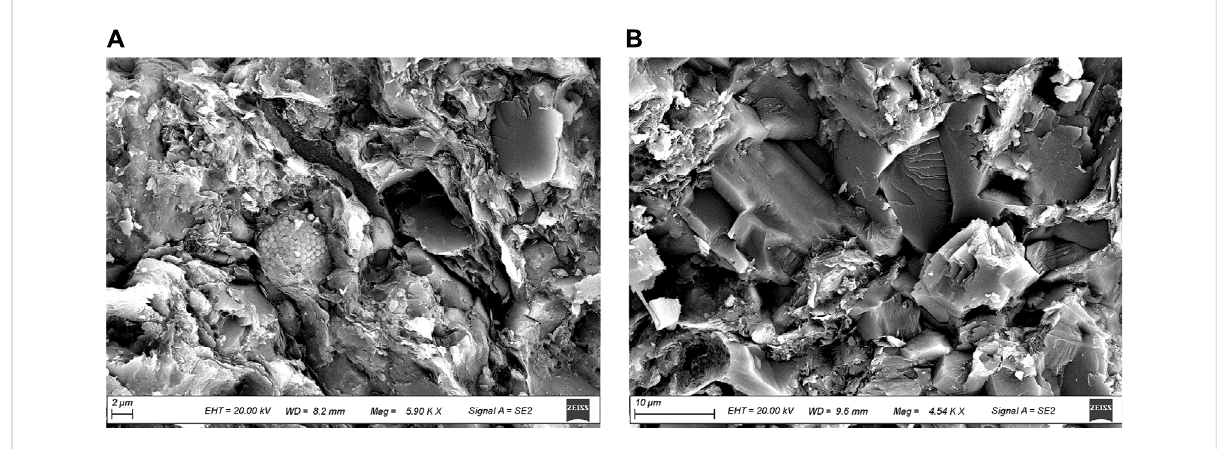
FIGURE 5 SEM micrographs of two thin-sections corresponding to the same depth as the samples 1 – 5 H and 1 – 6 V. (A) Micrograph shows fl ake illite, clastic grains, pelletized pyrite, organics, and micro-pores. (B) Micrograph shows the abundance of calcite wrapped by clay minerals, and inter-/ intra-grain pores.